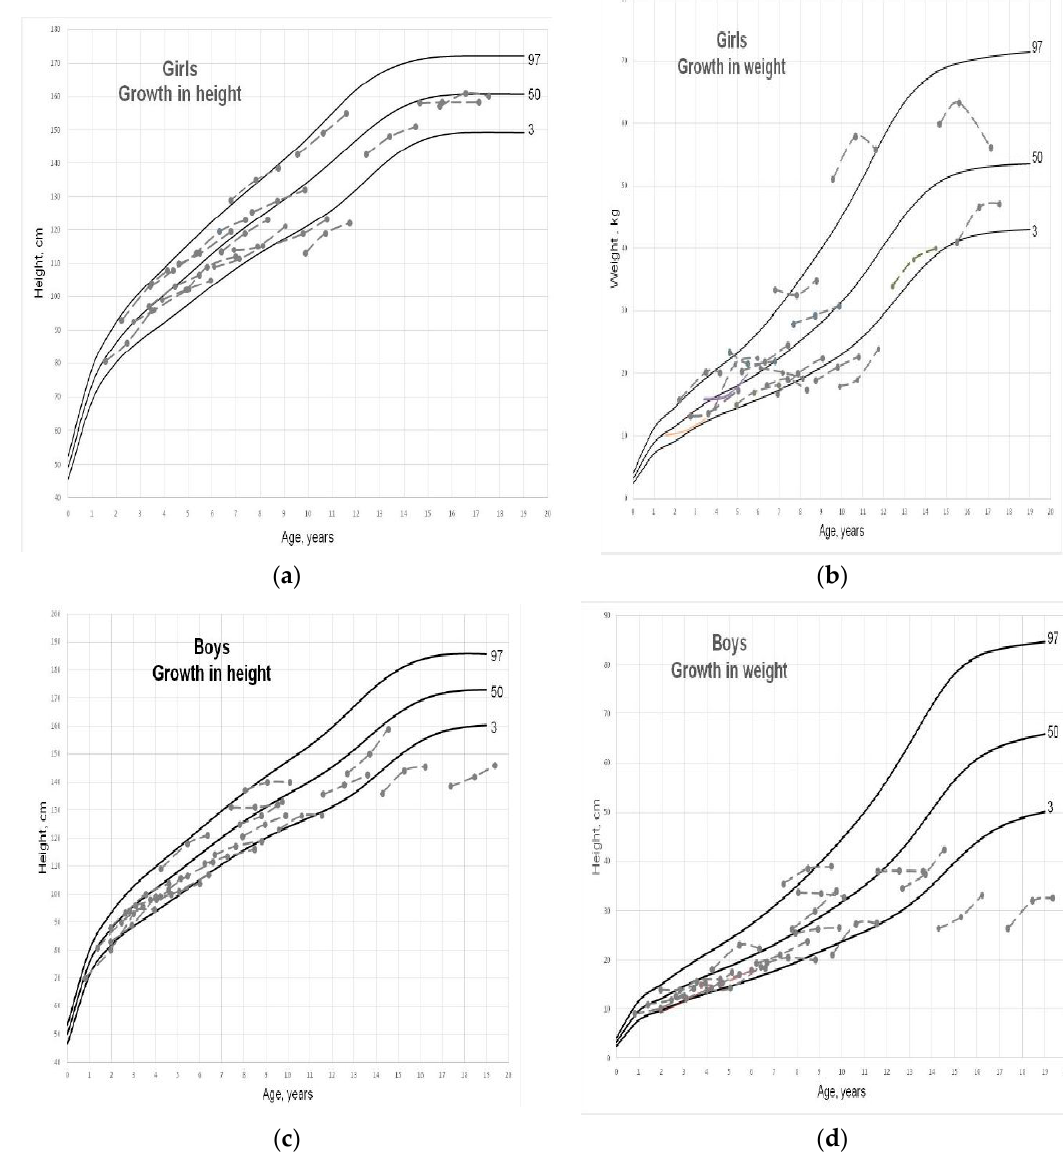
Figure 2. Individual growth curves showing height-for-age (median SDS) in girl ( a ). weight-for-age (median SDS) in girls ( b ), height-for-age (median SDS) in boys ( c ), weight-for-age (median SDS) in boys ( d ).